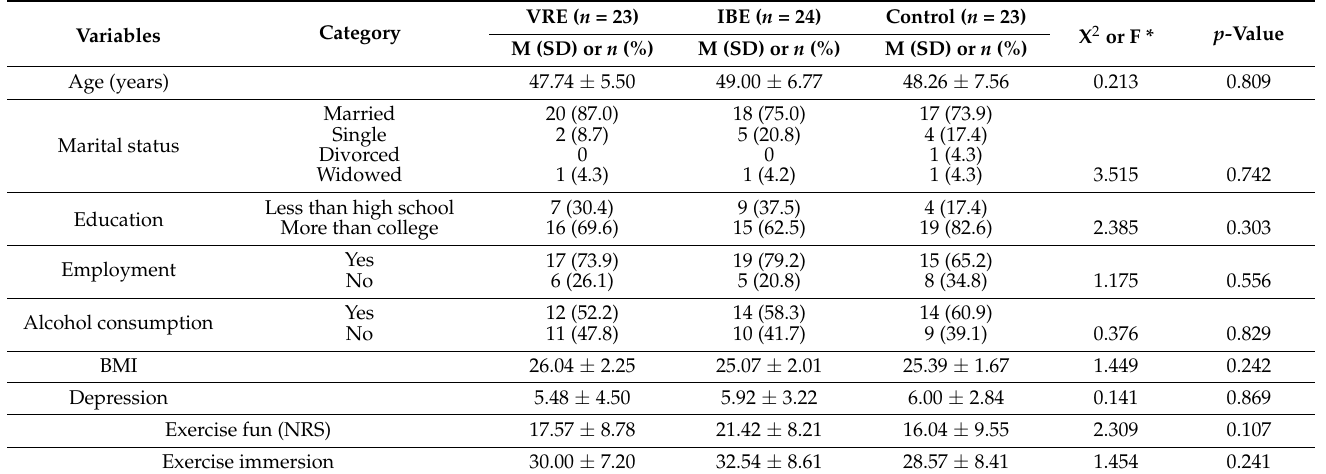
Table 1. Homogeneity of the participants’ characteristics and dependent variables among groups ( n = 70).